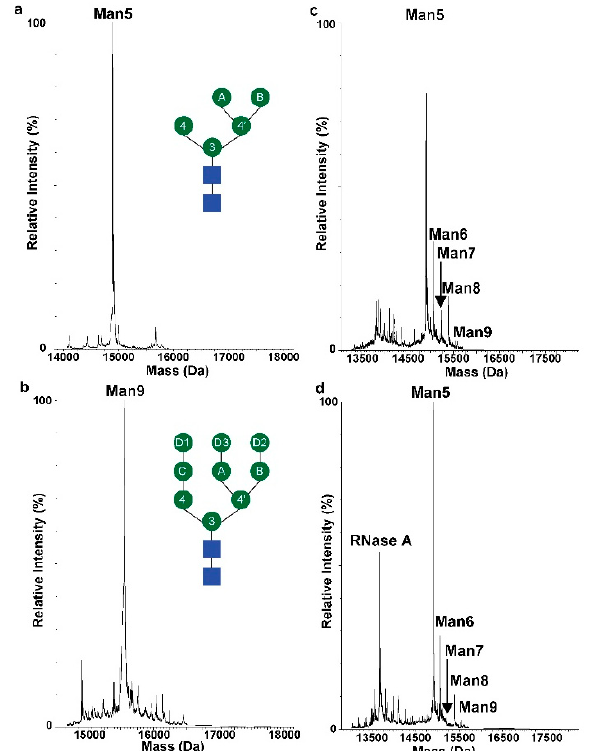
Figure 3. Deconvoluted ESI-MS spectra of ( a ) RNase B Man 5 , ( b ) RNase B Man 9 , ( c ) vendor 1 RNase B, and ( d ) vendor 2 RNase B. RNase B Man 5 and RNase B Man 9 are singly glycosylated. Both vendor 1 and vendor 2 contain a population of high-mannose glycan with predominantly GlcNAc2Man5. The vendor 2 sample did have a significant population of RNase A that was not present in Vendor 1’s sample.